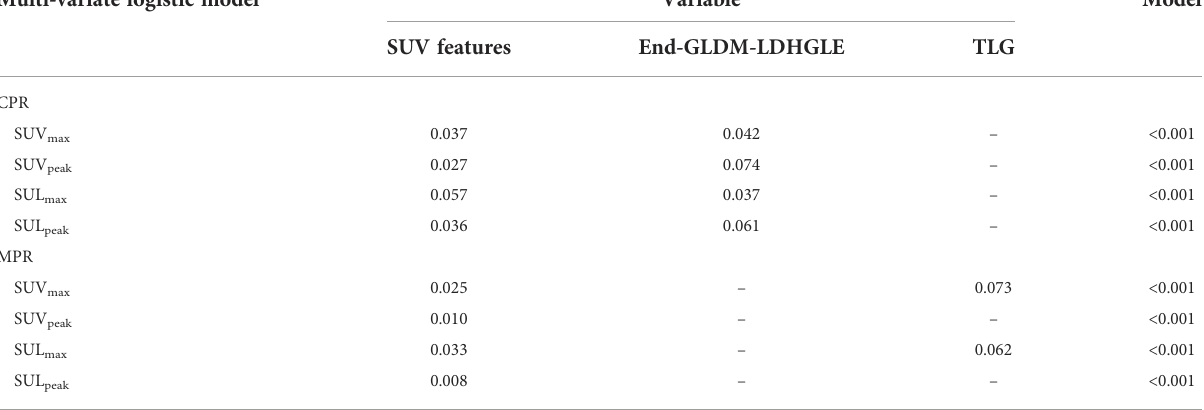
TABLE 5 Multi-variate results for complete pathological response (CPR) and major pathological response (MPR) prediction with preoperative PET features. Multi-variate logistic